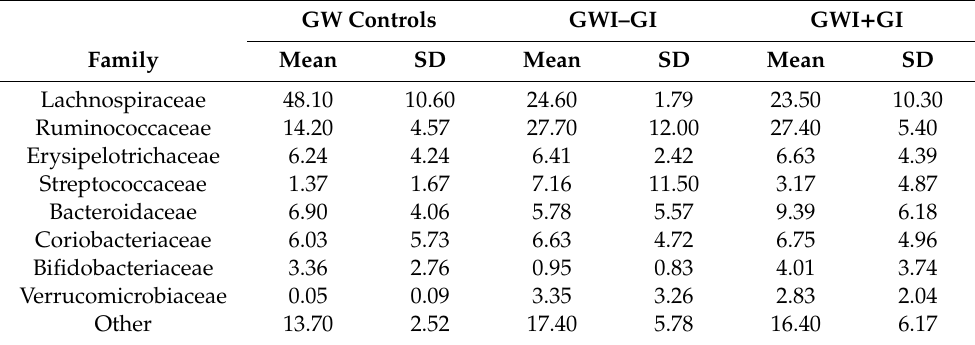
Table 5. Percent relative abundance at the Family Level by